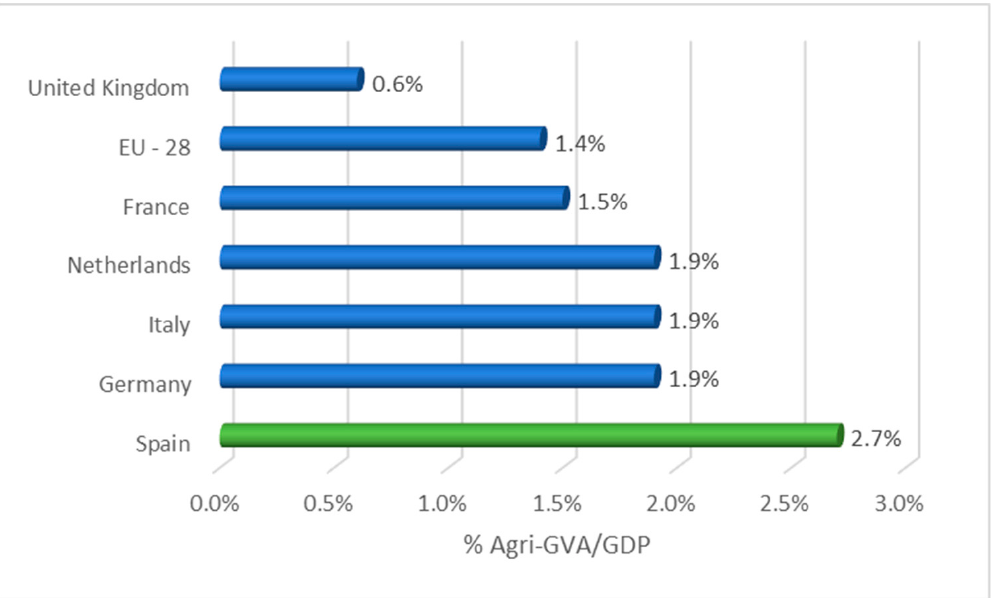
Figure 2. Direct contribution of agricultural GVA to the total GDP of the economy (2017) [16].